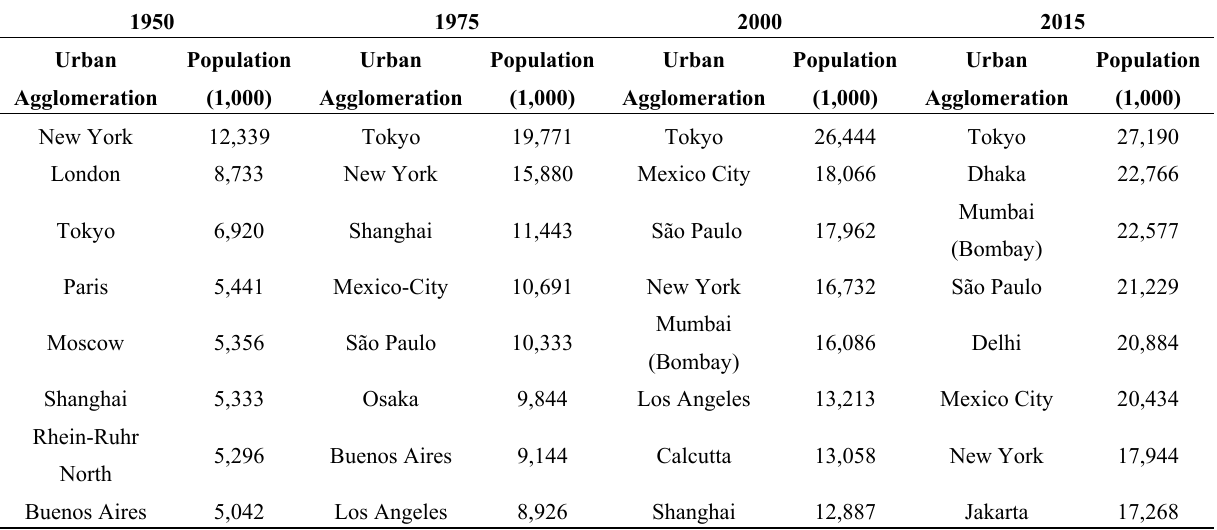
Table 2. The populations of the eight biggest urban agglomerations of the world (for the years 1950, 1975, 2000 and 2015)